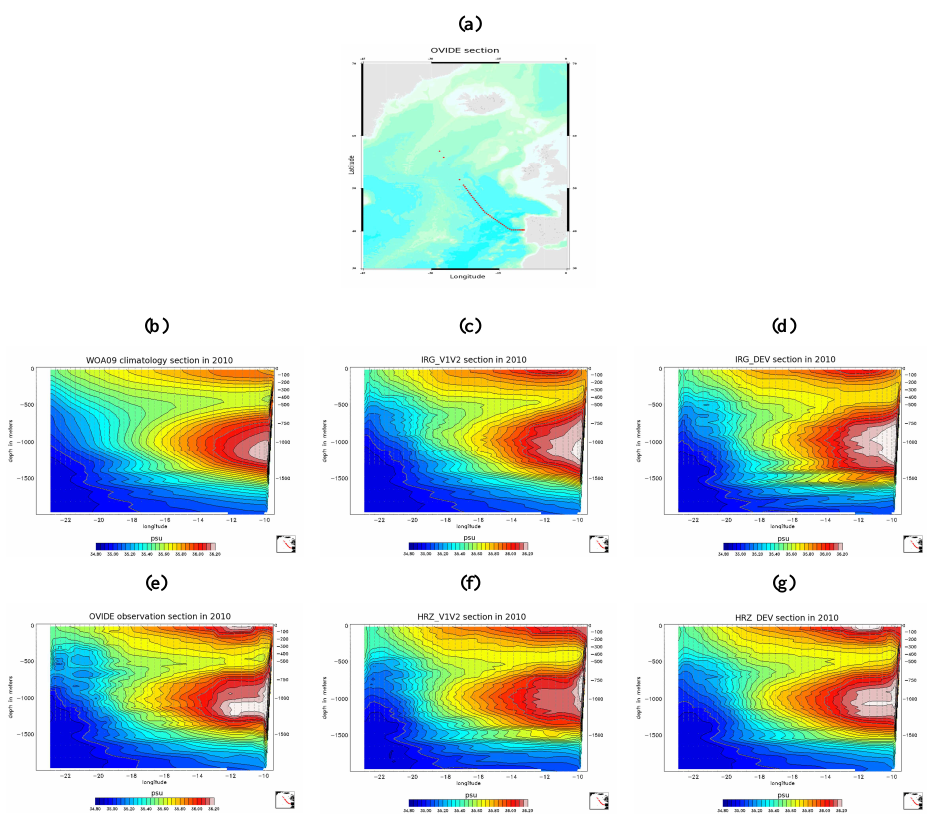
Fig. 21. Salinity (psu) along the OVIDE section (a) , in 2010 from WOA09 climatology (b) , IRG V1V2 (c) , IRG DEV (d) , in situ observations from CORIOLIS database (e) , HRZ V1V2 (f) , and HRZ DEV (g) . The contour interval is 0.05psu.